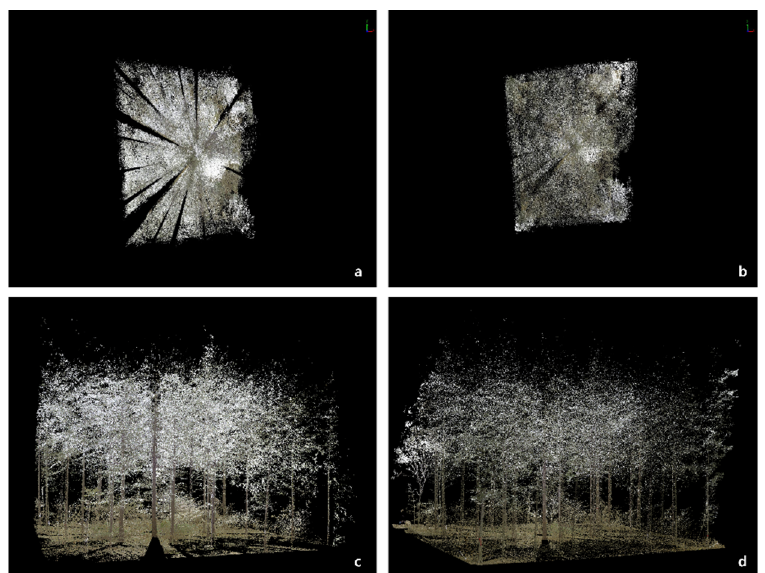
Figure 6. Comparison of the single- and multi-scan TLS showing the occlusion effect. ( a , c ) are examples of the corn-shaped occlusion that hindered the single-scan method, while ( b , d ) show that the corn-shaped occlusion was controlled by the multi-scan method to obtain all point clouds.